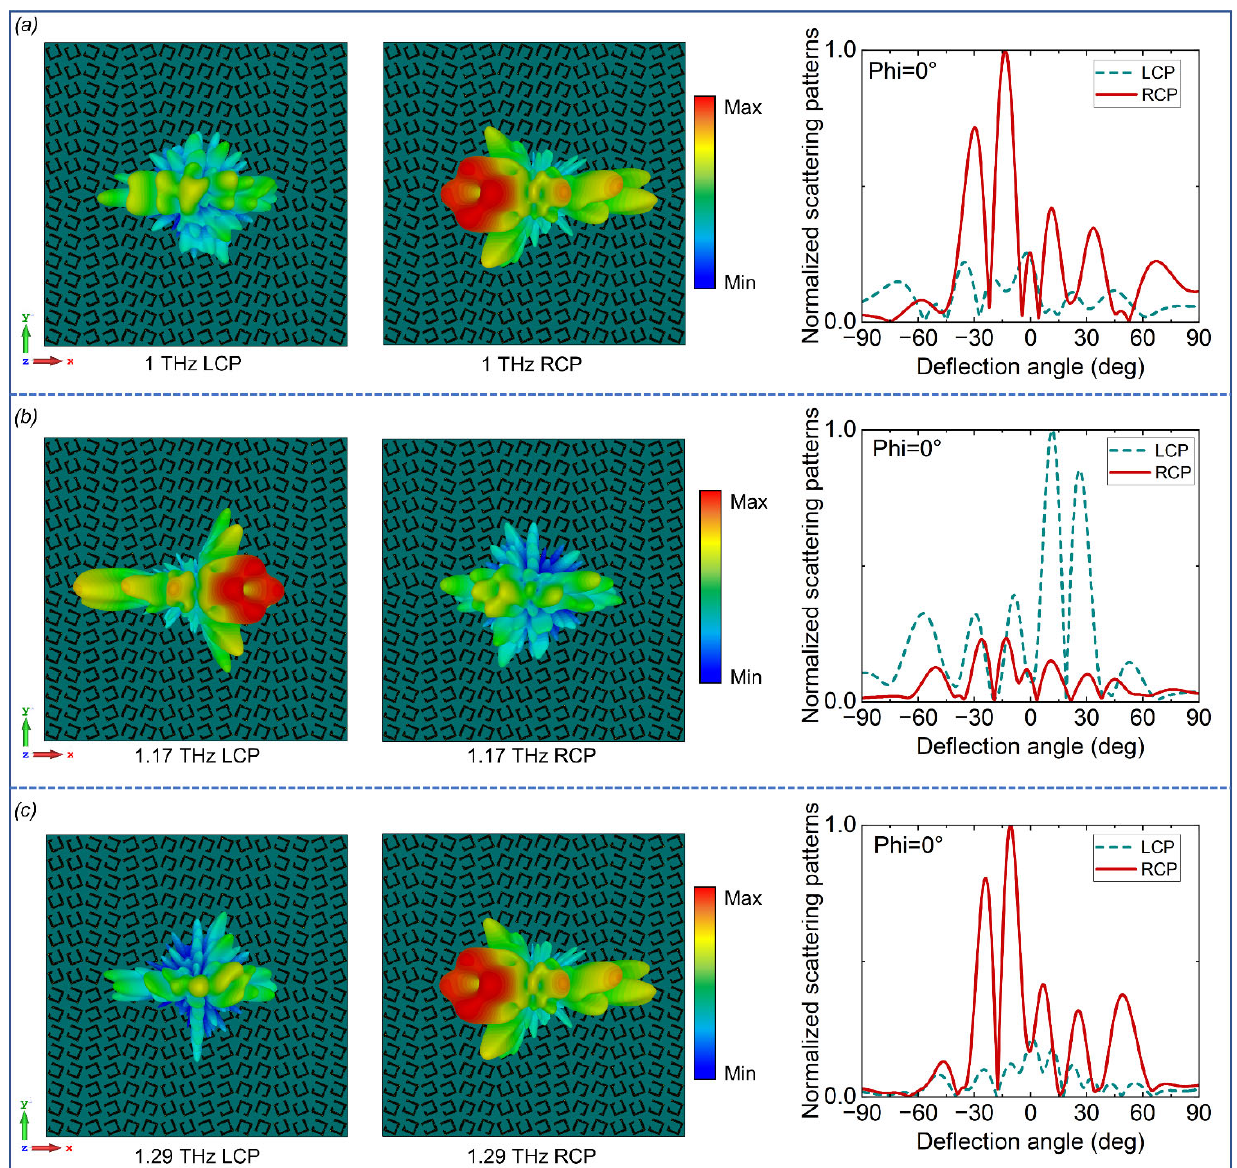
Figure 9. Simulation of the 3D far-field scattering patterns and normalized 2D scattering patterns of the 2-bit metasurface array at the azimuth angle phi = 0 ◦ . ( a ) The array under the normal incidence of LCP/RCP at 1 THz; ( b ) The array under the normal incidence of LCP/RCP at 1.17 THz; ( c ) The array under the normal incidence of LCP/RCP at 1.29 THz.